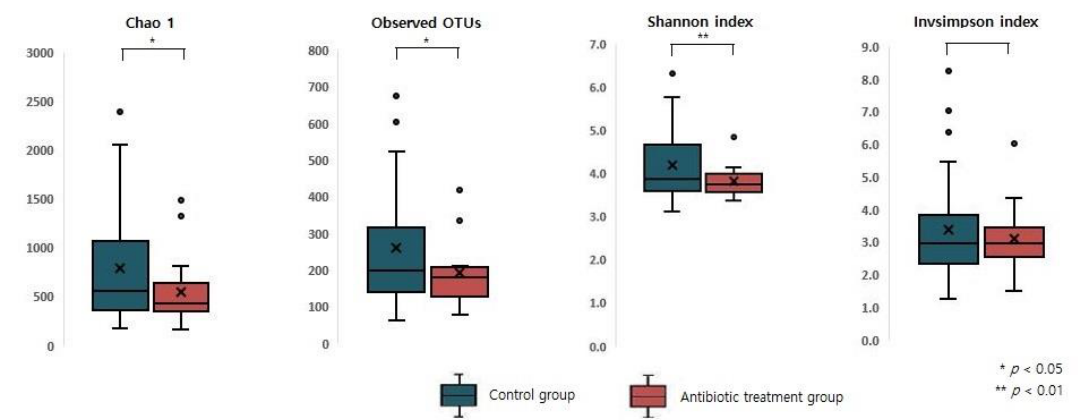
Figure 5. Difference of alpha diversity between the control and antibiotic treatment groups. A three-dimensional principal coordinates analysis (3D PCoA) was performed to visualize the microbial community’s structure based on weighted and unweighted UniFrac distances. A significant change in the microbial community structure with antibiotic treatment was shown in the weighted UniFrac analysis (Figure 6a, p = 0.018), but it was not evident in the unweighted UniFrac analysis (Figure 6b, p = 0.247).